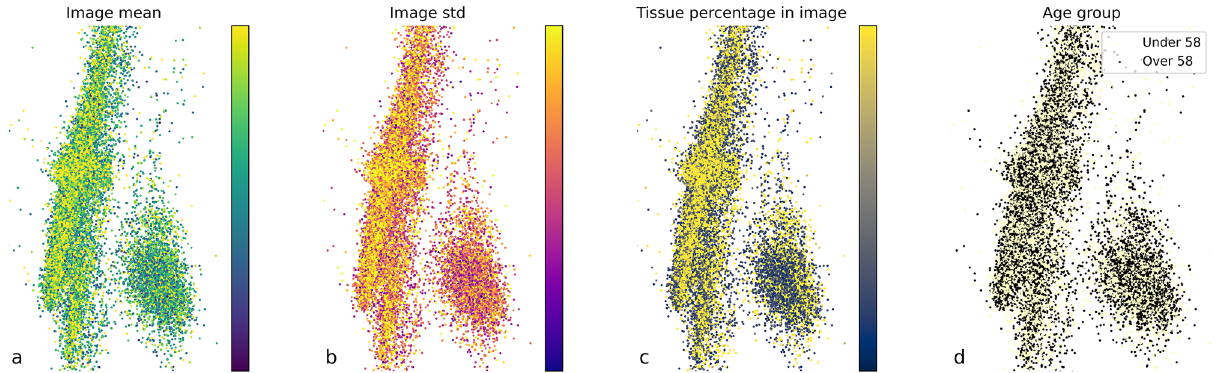
Figure 5. PIP PCA projections for all A, B and C data. Each point represents the PIPs for one image; its color represents some statistic of that image. ( a ) The mean pixel value (Gray scale intensity of each pre-processed image) is relatively evenly distributed in the space. ( b ) The standard deviation of pixel values is also randomly distributed. ( c ) The percentage of pixels in the image that are of tissue does vary in one of the principal components. ( d ) Age groups are homogenous in PIP space. In accordance with age group prediction being impossible from PIPs. PCA naturally compresses the redundant information from some derived PIPs without having to know which parameters are derived from which by the imaging